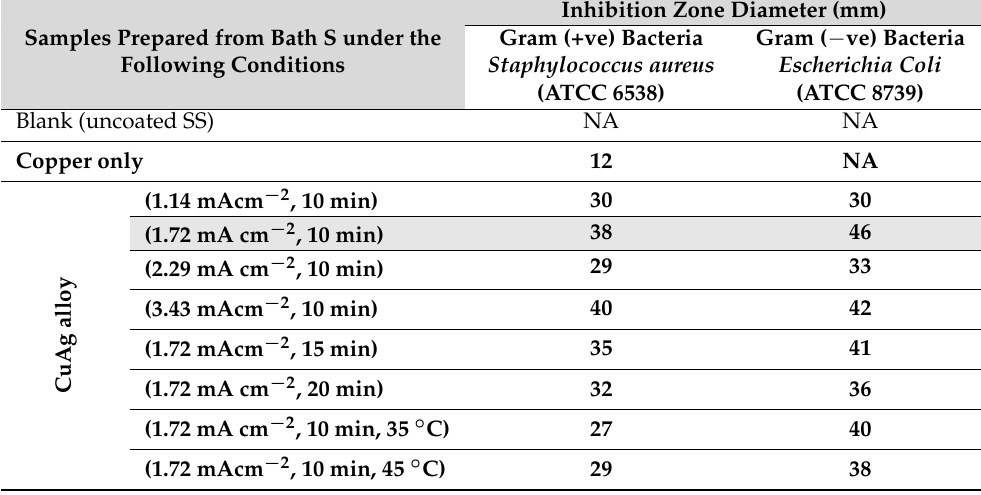
Table 4. The inhibition zone diameters of samples prepared at different operating